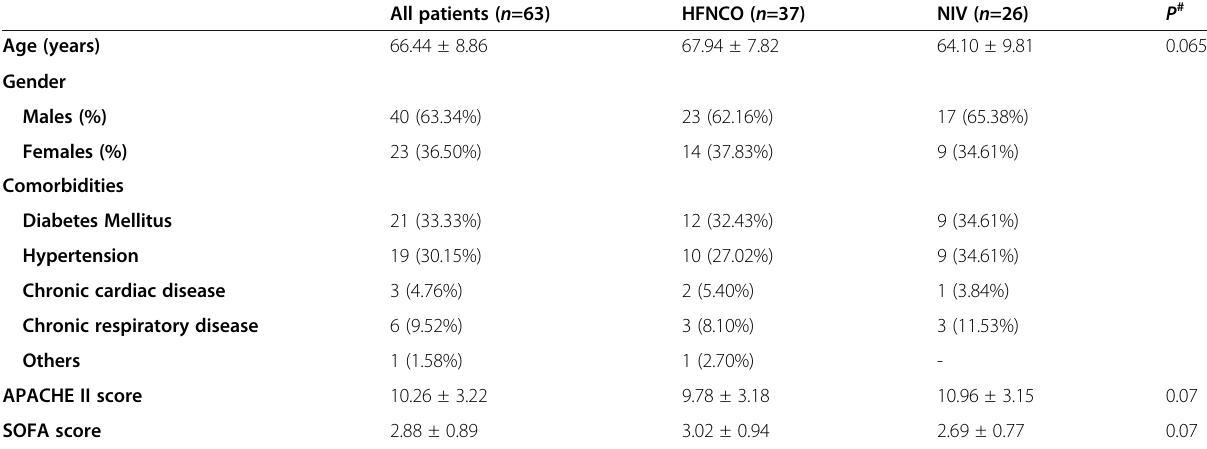
Table 1 Baseline characteristics of the included